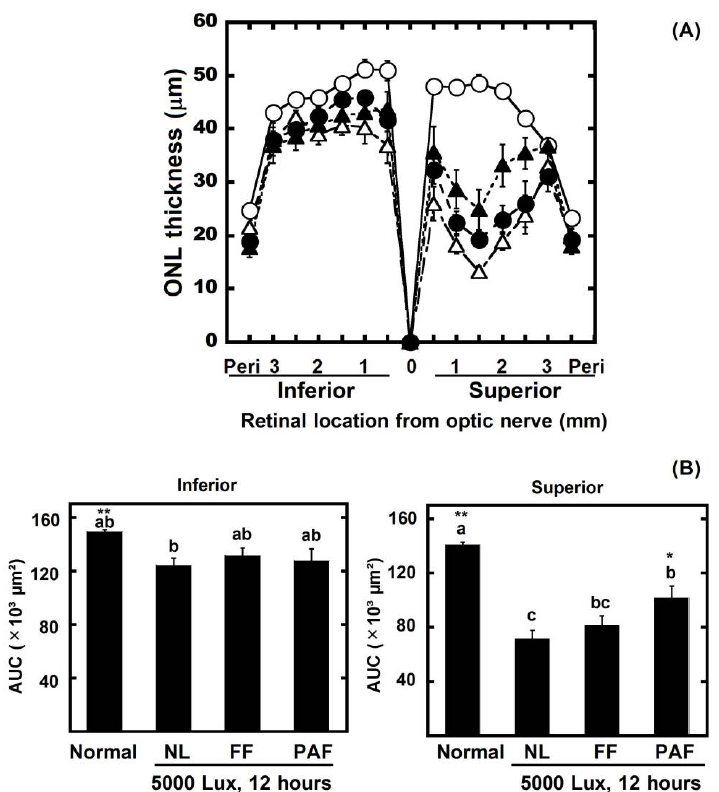
Figure 8. Protective effects of FF and PAF against light-induced retinal histologic damage. After ERG measurement, the ONL thickness was measured in the retinal sections. ( A ) The ONL thickness in each experimental group is shown. The data are expressed as the mean ± standard error of the mean ( n = 6). Normal ( ○ ) indicates normal control, no light exposure, untreated; NL ( △ ) indicates negative control, light exposure, administration of solvent; FF 300 (●) indicates light exposure, administration of FF 300 mg/kg of body weight; PAF 300 ( ▲ ) indicates light exposure, administration of PAF 300 mg/kg of body weight; and peri indicates the periphery 100 µm from the superior and inferior edges of the retina; ( B ) Area under the curve (AUC) of Figure 8A. The left graph indicates inferior, and the right graph indicates superior. Data represent the mean ± SEM ( n = 6). These data show the results of analysis by Tukey’s method and Dunnett’s method. Alphabets (a, b, and c) indicate values that differ significantly between each group ( p < 0.05) tested by Tukey’s method. Asterisks indicate values that differ significantly to the negative control tested by Dunnett’s method (* p < 0.05, ** p < 0.01).